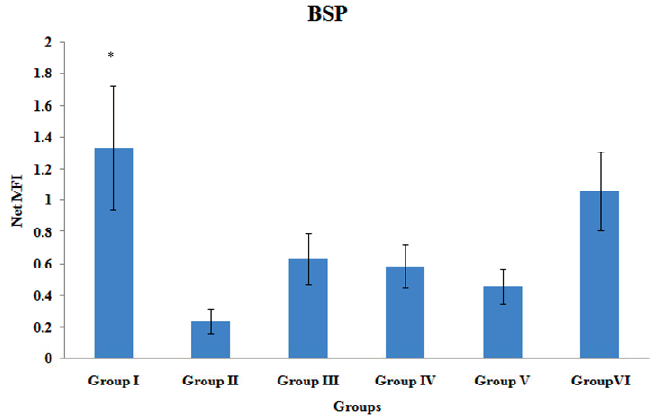
Figure 5. BSP Gene Expression. Samples were normalized to GAPDH MFI (Median FluorescenceIntensity). Values were expressed as mean ± SEM. Group I: sham-operated